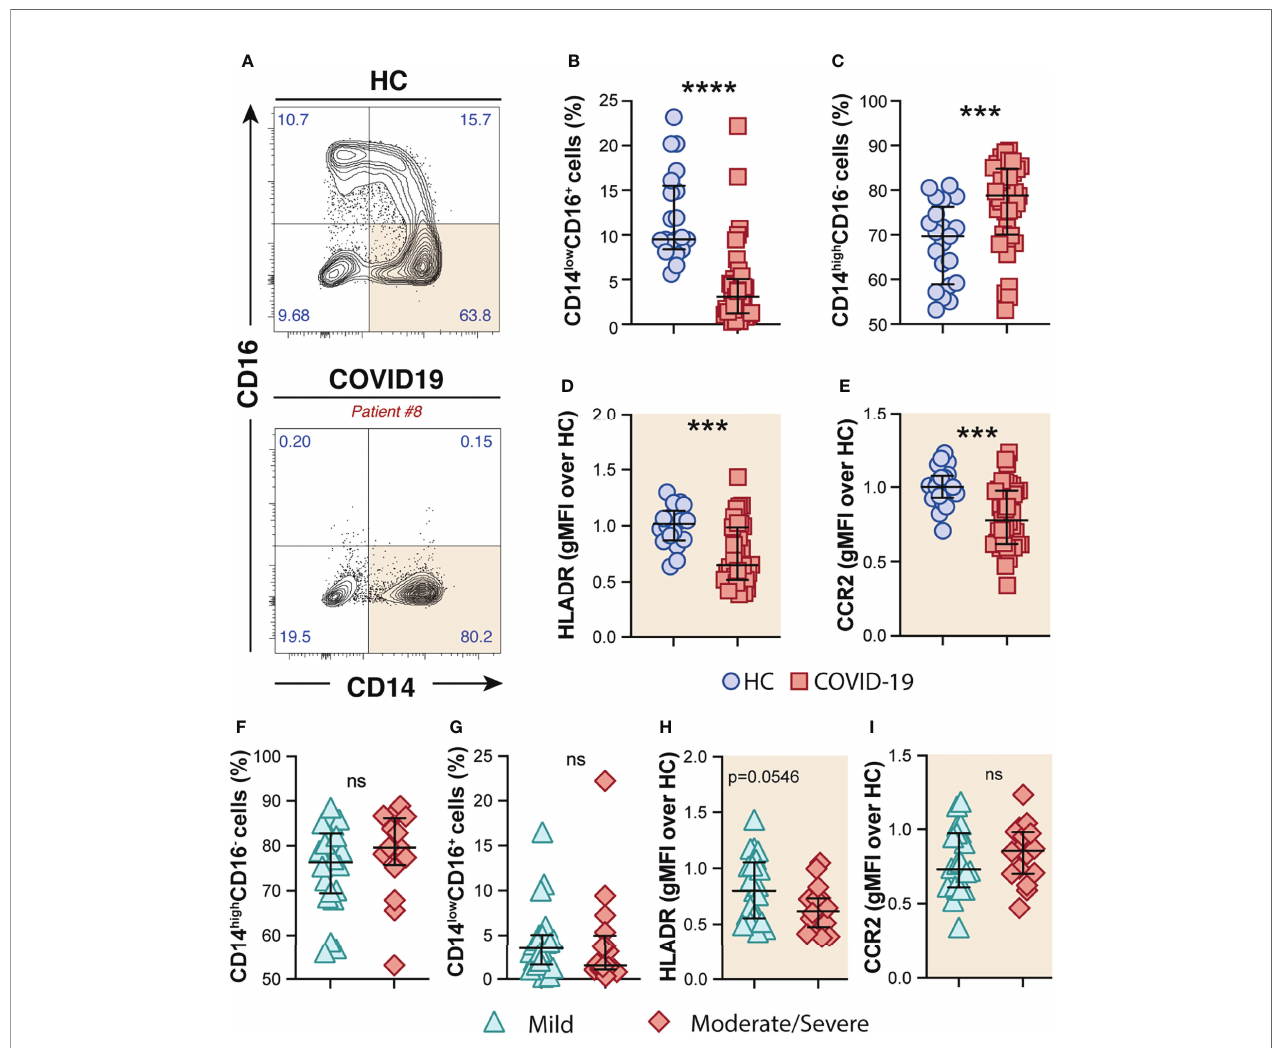
FIGURE 1 | Phenotypic changes in circulating monocyte subsets during COVID-19. (A) Representative FACS plots showing the distribution of the monocyte subsets de fi ned by CD14 and CD16 markers in COVID-19 patients. Percentage of CD14 low CD16 + (B) and CD14 high CD16 − (C) monocytes among circulating mononuclear myeloid cells (HLADR + CD2 − CD3 − CD19 − CD20 − CD56 − CD66 − ) were compared between healthy controls (HC, n = 21) and COVID-19 patients (n = 38). Data are presented as median with interquartile range. The geometric mean fl uorescence intensity (gMFI) of HLA-DR (D) and CCR2 (E) expression on CD14 high CD16 − monocytes was compared between HC (n = 21) and COVID-19 patients (n = 38). Percentage of CD14 high CD16 − (F) and CD14 low CD16 + (G) monocytes and also MFI of HLA-DR (H) and CCR2 (I) expression on CD14 high CD16 − monocytes is compared between COVID-19 patients experiencing mild symptoms (n = 22) versus moderate to severe forms of COVID-19 (n = 16). Data were analyzed using the Mann – Whitney test. ***P < 0.001, ****P < 0.0001; ns , not signi fi